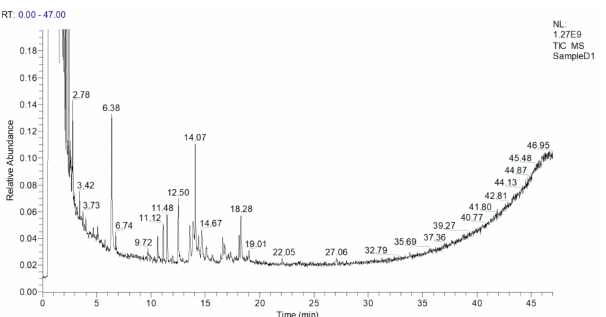
Figure 1. GC-MS chromatogram of the ethylacetate fraction of Chrozophora tinctoria . The numbers show the retention times of various compounds. Table 1. Bioactive compounds identified in the ethylacetate fraction (EAC) through GC-MS. Peak